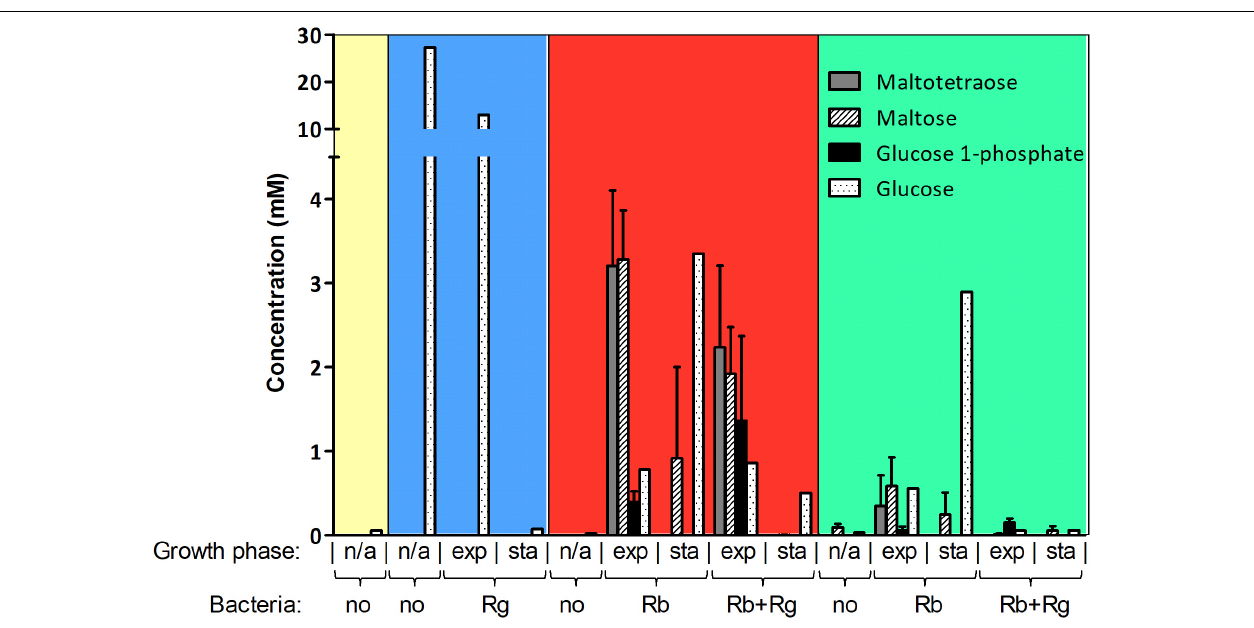
FIGURE 2 | Concentration of starch degradation products in the spent media. The concentrations were determined by 1 H NMR and the values are averages of 2 to 5 replicates. The error bars correspond to standard deviations. Results presented in the blue, red and green boxes come from growth assays with Glc, SS and RS as sole carbon source, respectively. Results from the YCFA medium alone, without carbon source, are presented inside the yellow box. Abbreviations: exp, exponential; sta, stationary; n/a,